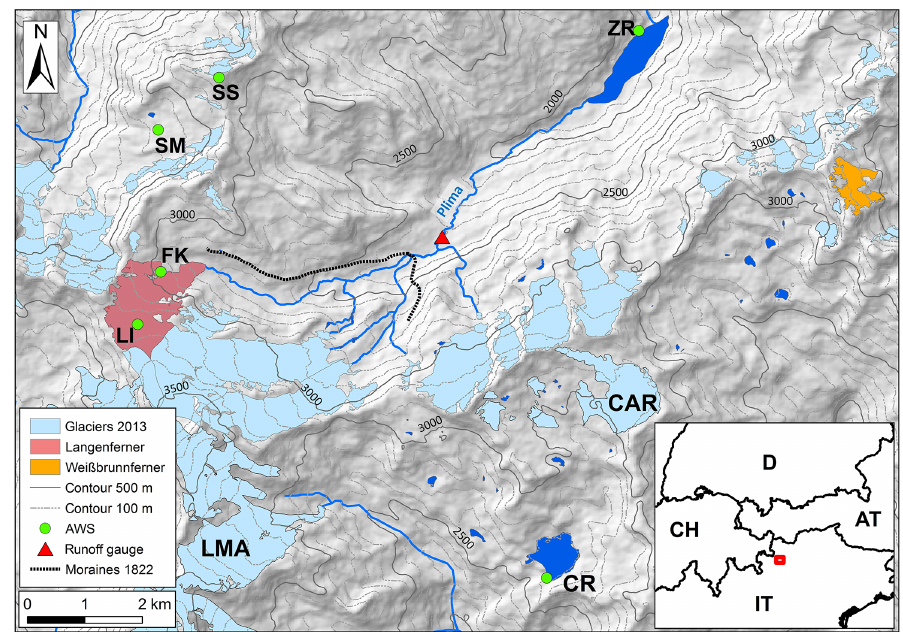
Figure 1. Overview of the study area. Langenferner is shown in red, Weißbrunnferner in orange and other glaciers in light blue (glacier outlines of 2013 derived from ALS; Galos et al., 2015). Green dots indicate the automated weather stations referred to in this study: Zufritt reservoir (ZR), Schöntaufspitze (SS), Sulden Madritsch (SM), Felsköpfl (FK), Langenferner Ice (LI) and Careser Dam Station (CR). The labels LMA and CAR refer to two other glaciers with mass balance measurements: La Mare and Careser (e.g., Carturan et al.,